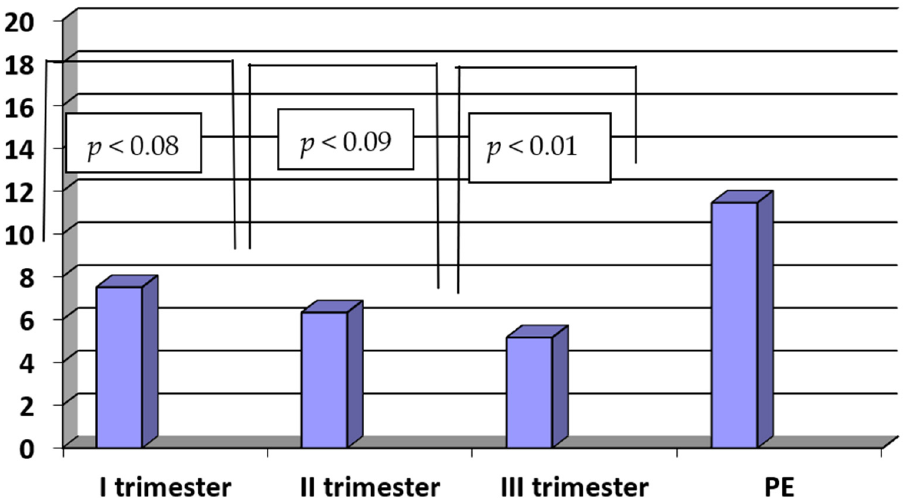
Figure 4. The concentrations of sENG (ng/mL) in sera of patients with PE (n = 35) and in sera of women in the first, second and third trimesters of normal pregnancy (n = 45).